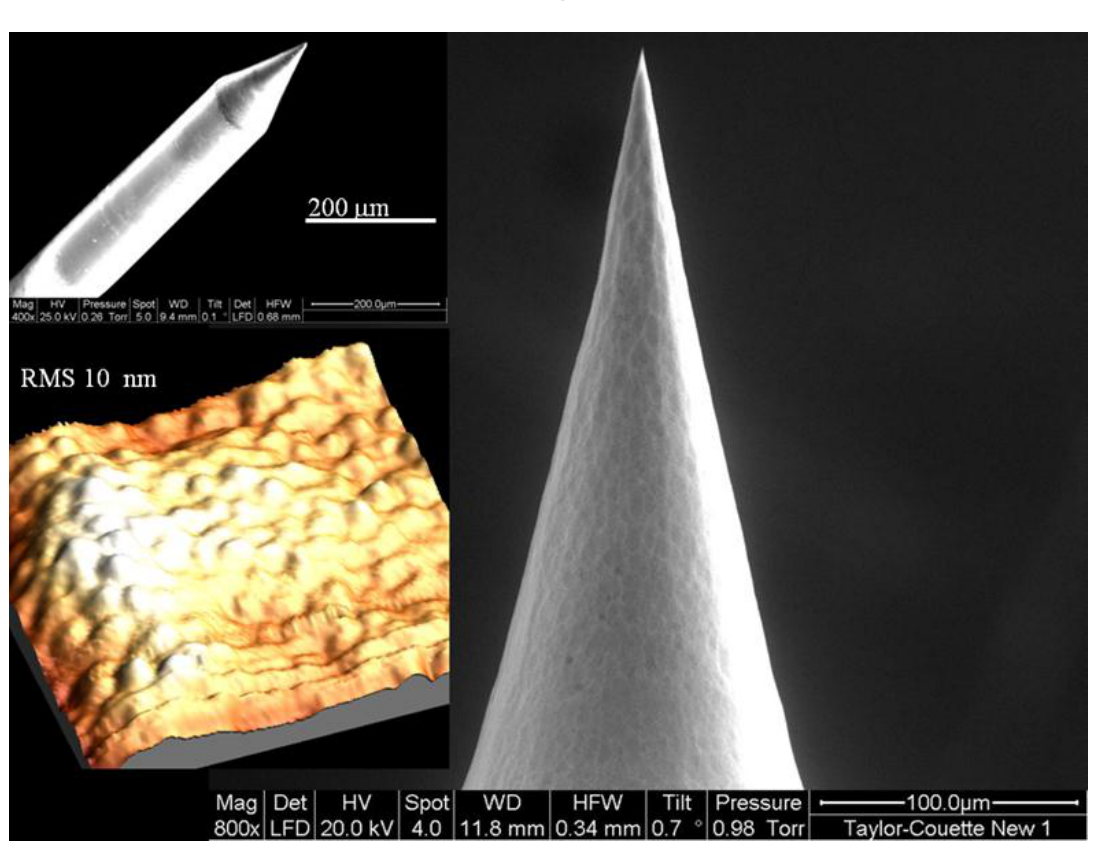
Figure 2. Example of a nanotip obtained using the fabrication method described in Section 2.3. In the left top a general view showing a taper length of about 200 µm and a large cone angle (about 40°), while in the left bottom an AFM image (10 µm × 10 µm) is reported, with an estimated roughness of about 10 nm. On the right panel is reported a zoom on the distal end, showing an apex angle of about